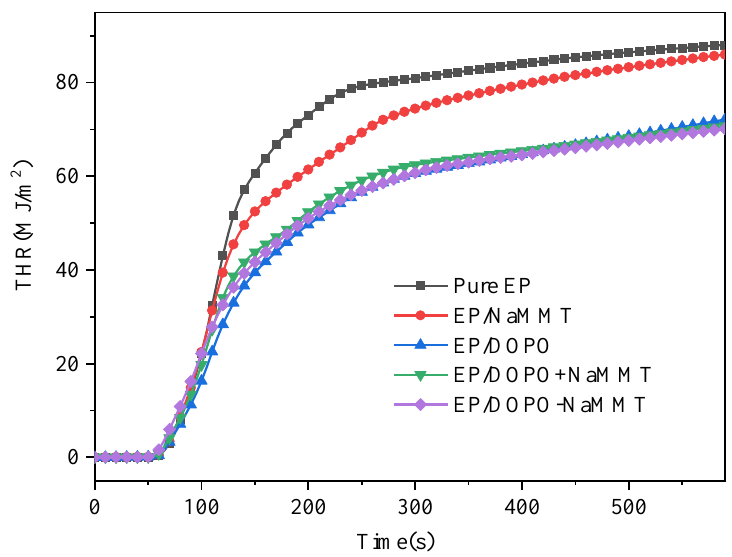
Figure 9. THR curves of epoxy resin composites.